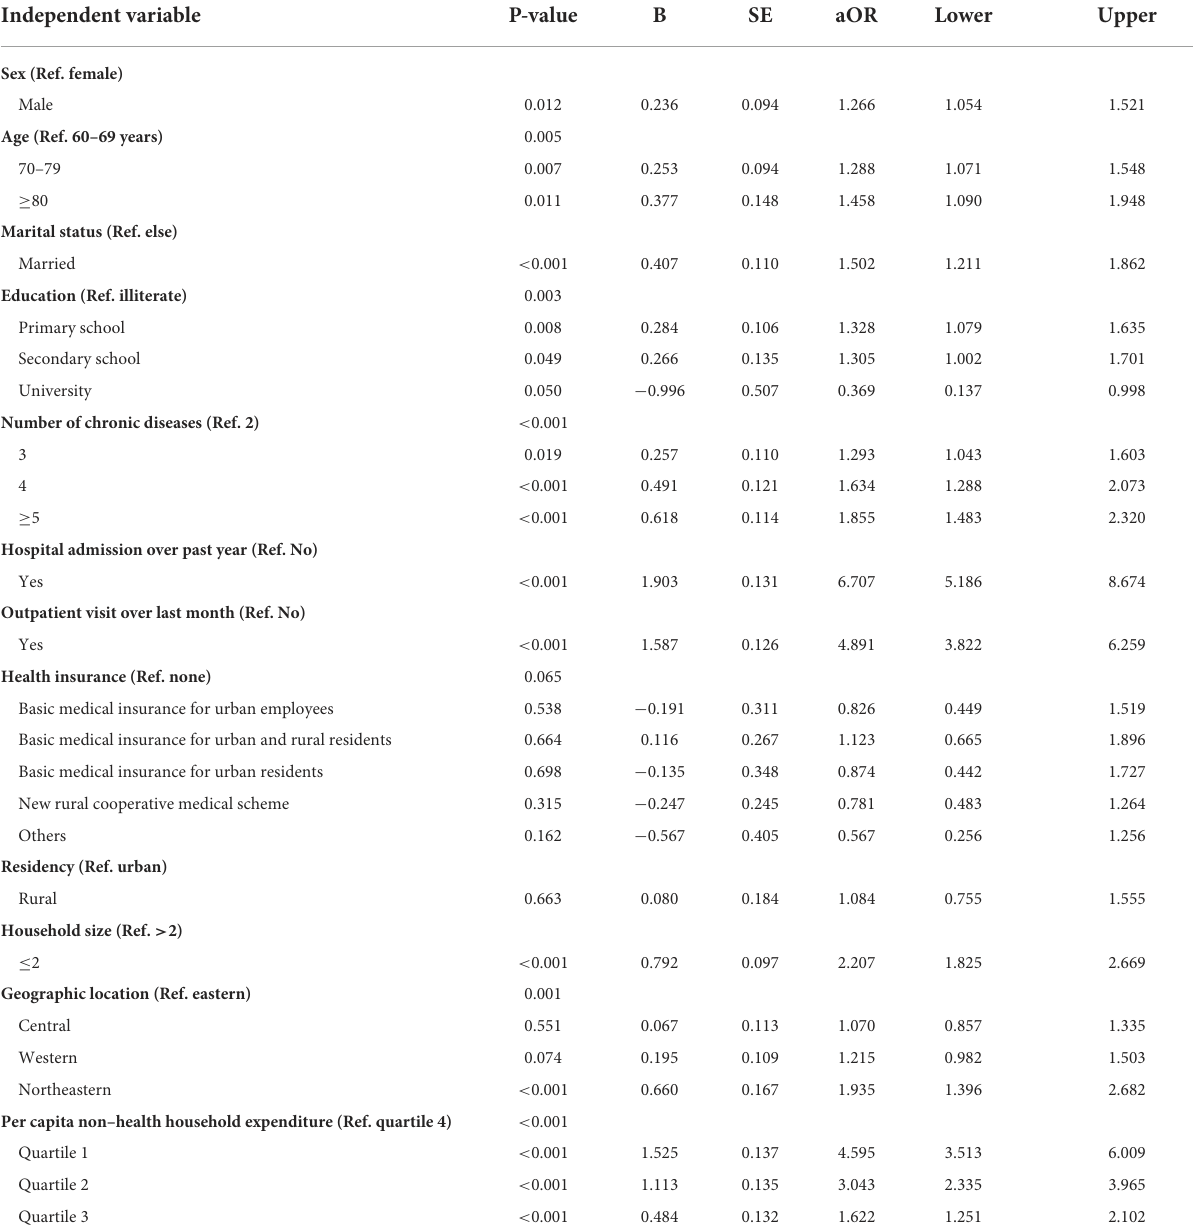
TABLE 4 Predictors of incidence of catastrophic health expenditure: Results of logistic regression model ( n =